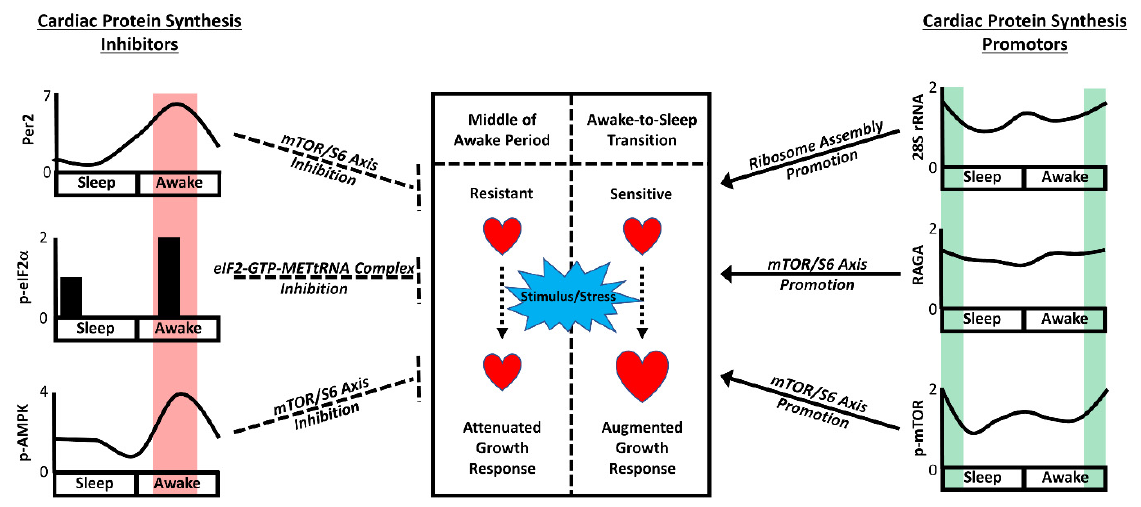
Figure 3. Circadian Orchestration of Anti- and Pro-Growth Mechanisms in the Heart. As highlighted in the figure, the heart is primed for growth at the awake-to-sleep transition, through coordinated alignment of mechanisms promoting protein synthesis at this time (green shaded area). Conversely, the cardiac growth response is greatly hindered in the middle of the awake period, due to elevated PER2, p-eIF2 α , and AMPK at this time (red shaded area).